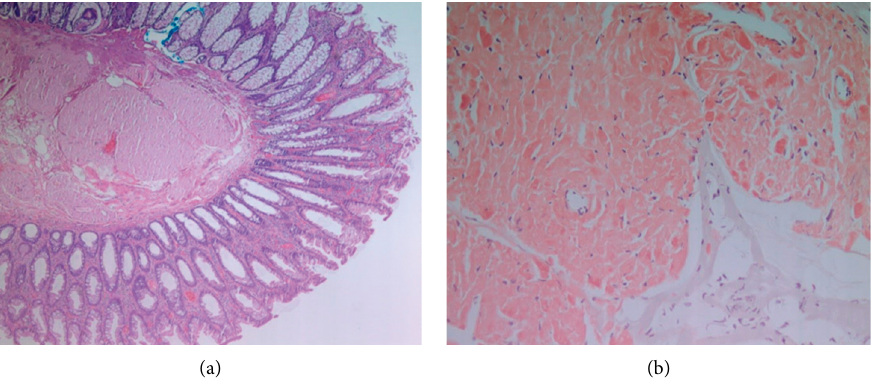
Figure 2: Sigmoid colon polypectomy showing benign colonic mucosa with hyperplastic changes and submucosal accumulation of eosinophilic materials, which are S100, CD117, CD34, and SMA negative (excluding neuroma, GIST, and leiomyoma) (a). The material is positive for Congo red stain consistent with amyloids